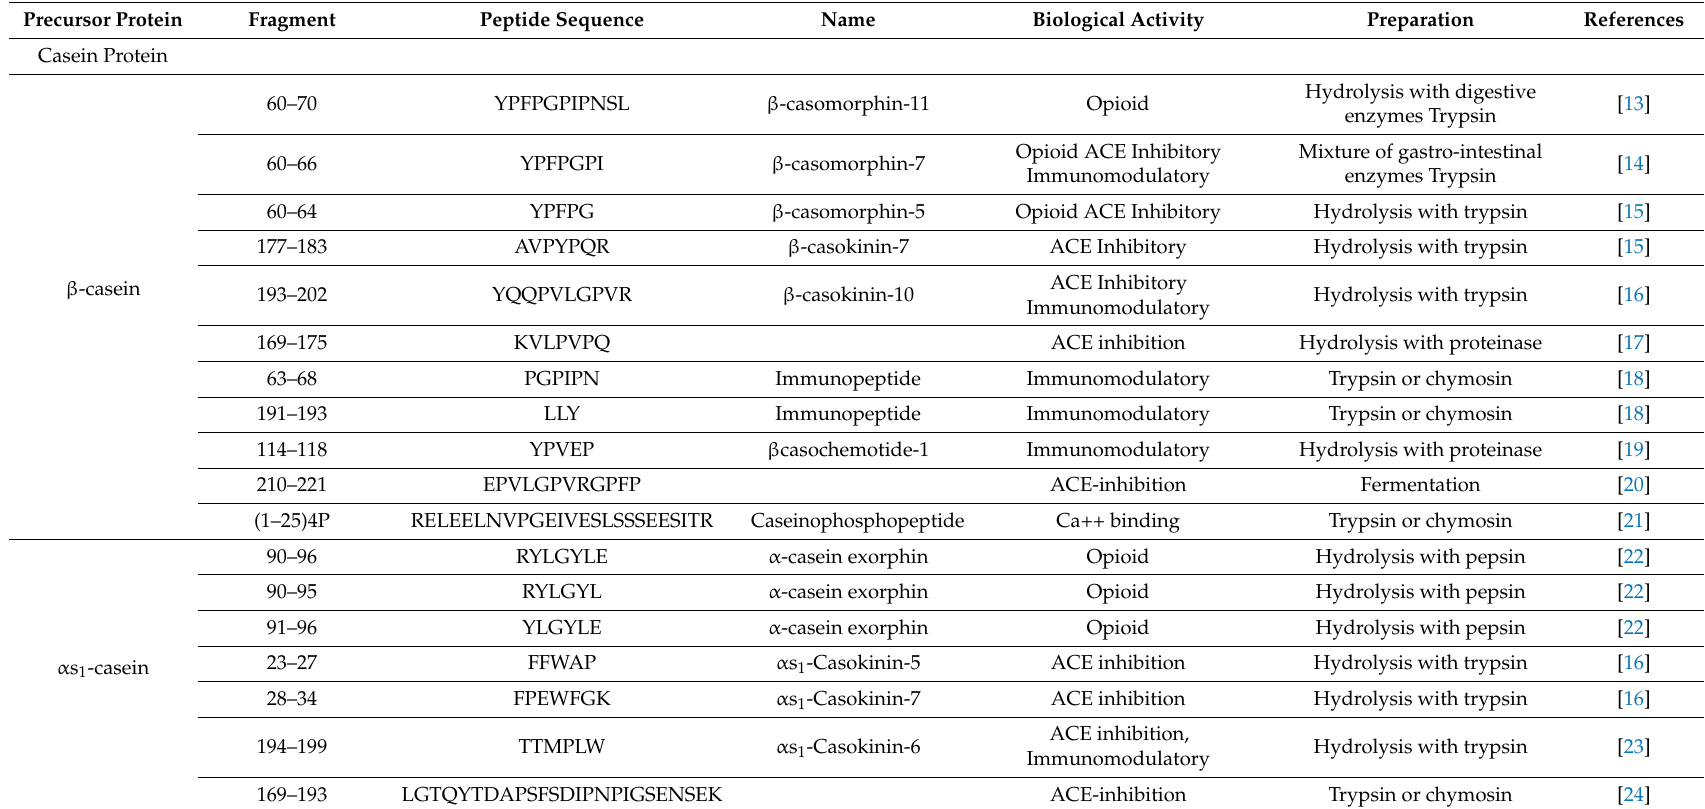
Table 1. Examples of bioactive peptides from